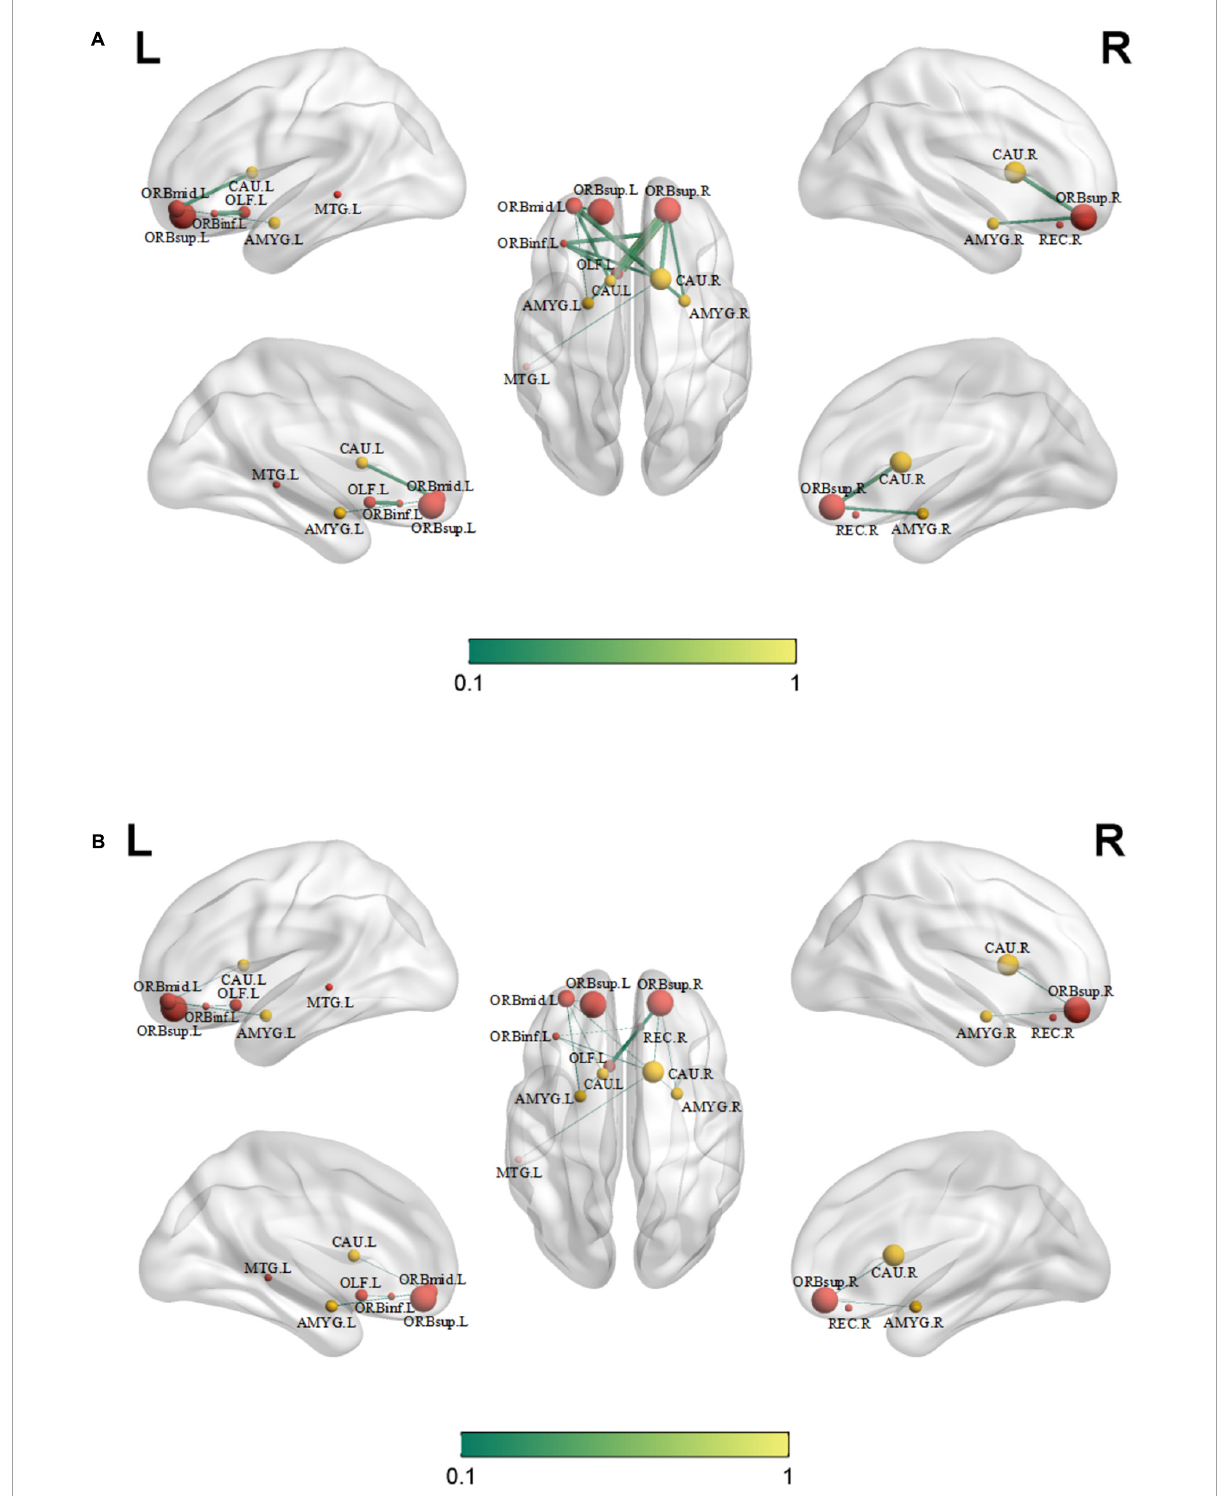
FIGURE2 Significant decreased functional connectivity. (A) Healthy controls and (B) knee osteoarthritis patients. ORBinf.L, left inferior orbitofrontal cortex; ORBsup.L, left superior orbitofrontal cortex; ORBsup.R, right superior orbitofrontal cortex; ORBmid.L, left middle orbitofrontal cortex; OLF.L, left olfactory cortex; REC.R, right gyrus rectus; AMYG.L, left amygdala; AMYG.R, right amygdala; CAU.L, left caudate; CAU.R, right caudate; MTG.L, left middle temporal